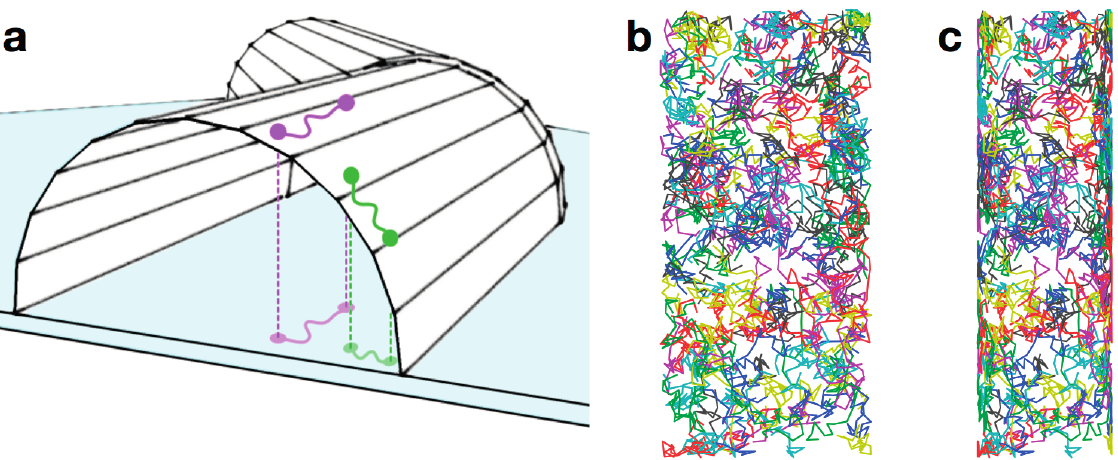
Figure 13. Effect of cell curvature on membrane-bound trajectories. ( a ) The purple and green paths are the same length on the surface of the cell, but the green path appears shorter than the purple path when projected onto the imaging plane (represented by the blue surface) due to the curvature of the cell membrane; ( b ) 200 two-dimensional random walks on the surface of a cylinder; ( c ) A projection of the walks in ( b ) onto a simulated two-dimensional detector shows a large degree of distortion at the edges of the projection due to the curved nature of the cell membrane. Figure from reference